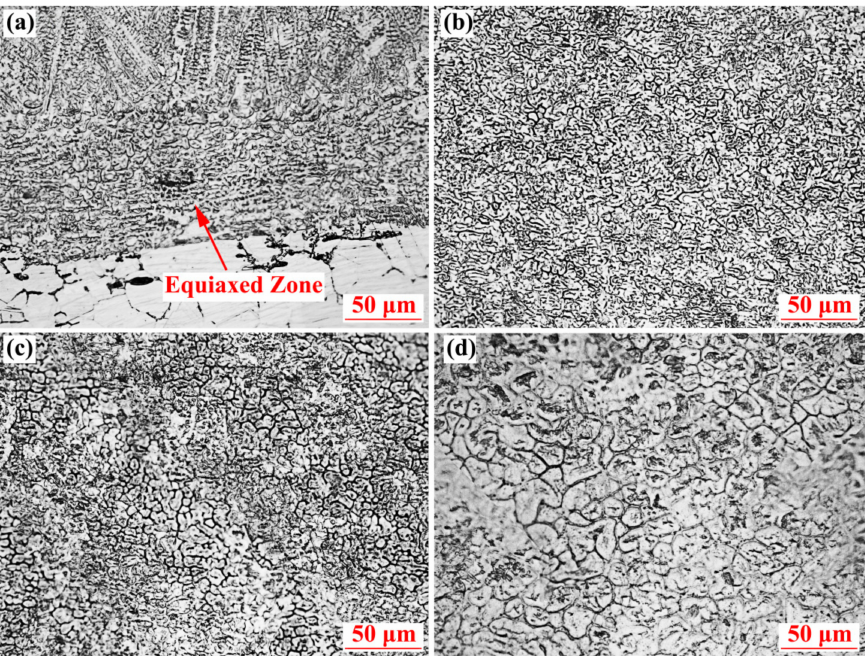
Figure 10. Comparison of crystal sizes in the equiaxed zone under di ff erent welding currents. The welding currents are ( a ) 16.5 kA, ( b ) 15 kA, ( c ) 14 kA, and ( d ) 13.5